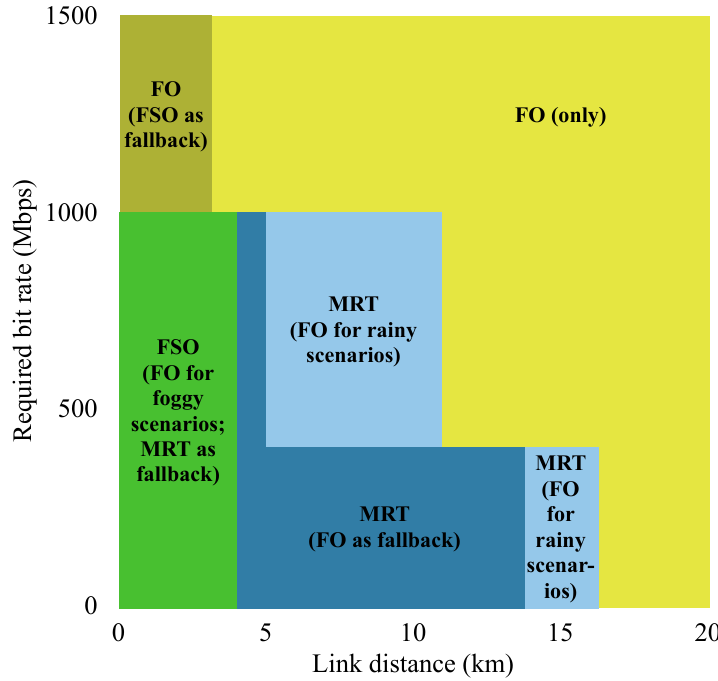
Figure 8. Summary of the cost-effective solutions for individual link deployment.